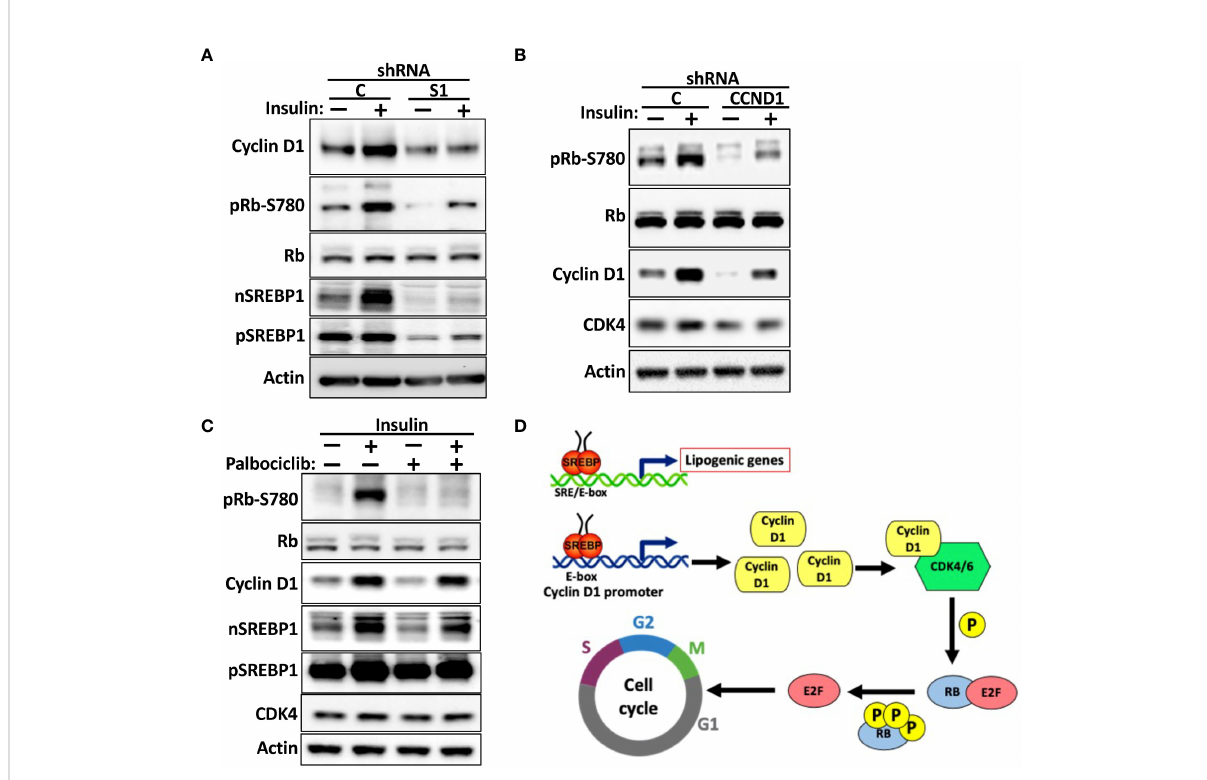
FIGURE 8 The SREBP1-dependent expression of cyclin D1 links insulin signaling to Rb phosphorylation. (A) MCF7 cells were transduced with lentiviruses expressing non-targeted (C) or SREBP1 ( S1 ) shRNA. After selection, the cells were serum-starved for 24 h, followed by an additional 2-h incubation in the absence or presence of insulin. The levels of cyclin D1, Rb, and nuclear ( nSREBP1 ) and precursor SREBP1 ( pSREBP1 ) and CDK4, and the phosphorylation of Rb on serine 780 ( pRb-S780 ) were analyzed by Western blotting. (B) MCF7 cells were transduced with lentiviruses expressing non-targeted (C) or cyclin D1 ( CCND1 ) shRNA and treated and processed as in (A) . (C) MCF7 cells were serum-starved for 24 h followed by a 2-h stimulation with insulin in the absence or presence of palbociclib (10 m M). The cells were processed and analyzed as in (A) . (D) Model. We propose that cells respond to growth-promoting signals, such as insulin or EGF, by activating SREBP1. The active SREBP1 molecules bind to an E-box in the promoter of cyclin D1, thereby enhancing the expression of the corresponding gene. The enhanced expression of cyclin D1 promotes the phosphorylation of Rb by activating cdk4/6, thereby promoting G1 progression. At the same time, SREBP1, especially SREBP1a, has the capacity to enhance the expression of lipogenic genes to support cell growth. Thus, the SREBP-dependent regulation of cyclin D1 could help coordinate cell cycle progression with increased lipid synthesis to support cell growth. This may be